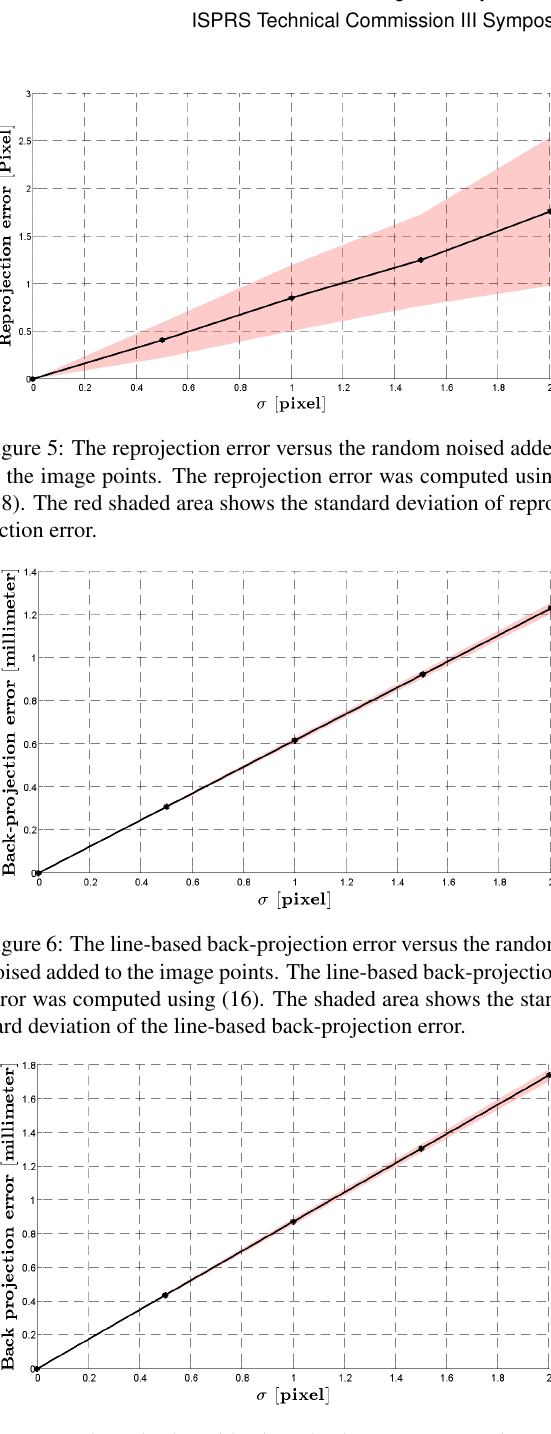
Figure 7: The point-based back-projection error versus the ran- dom noised added to the image points. The point-based back- projection error was computed using (19). The shaded area shows the standard deviation of the point-based back-projection error.